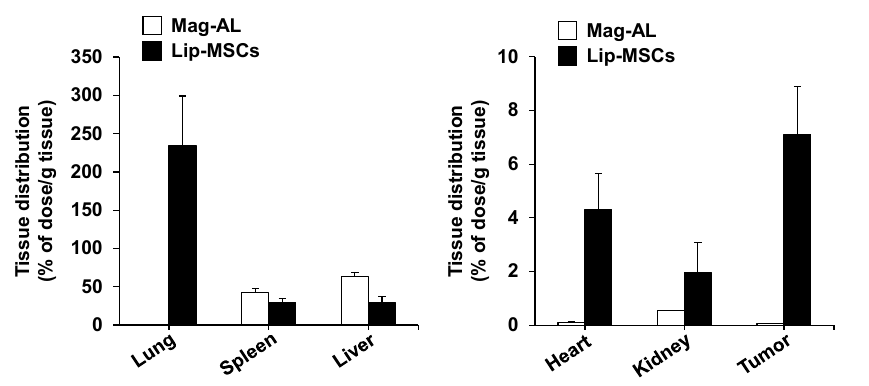
Figure 7. In vivo tissue distribution of Lip-MSCs after intravenous injection in tumor-bearing mice. 111 In-labeled Lip-MSCs (2 × 10 6 cells) or the corresponding amount of 111 In-labeled Mag-AL were intravenously injected into B16/BL6 tumor-bearing mice, and the accumulated amount of each tis- sue was measured at 48 h after the administration. Each value represents the mean + SD ( n =